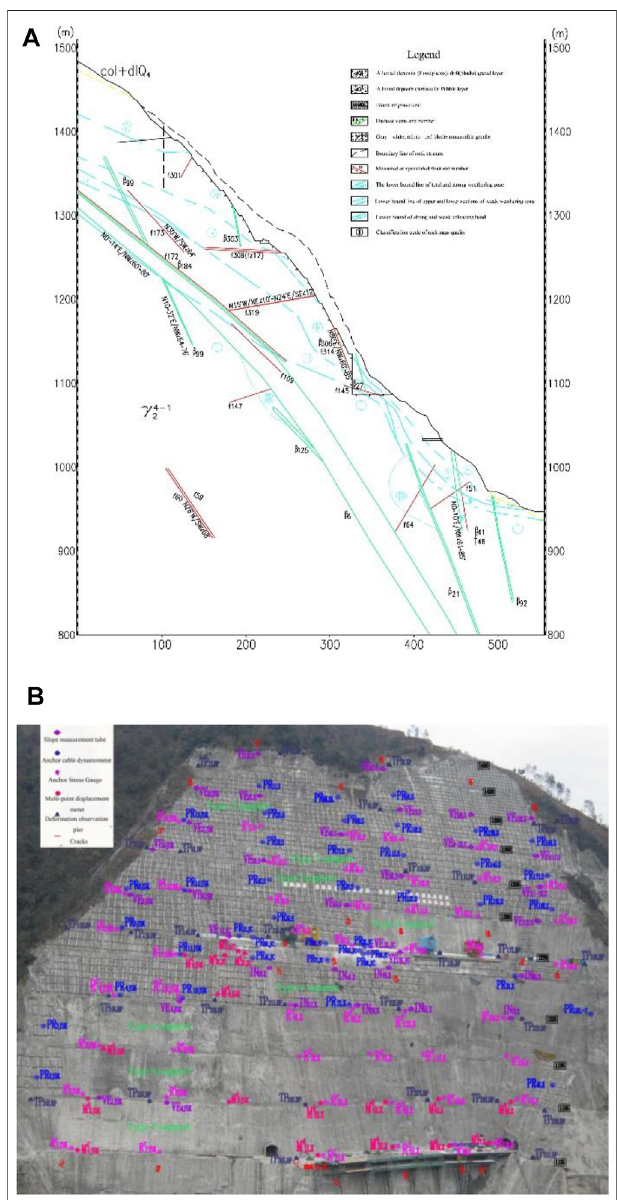
FIGURE 4 | (A) Geological structure diagram of LPI section of the left bank slope. (B) Layout of excavation support and deformation monitoring for the left bank slope.